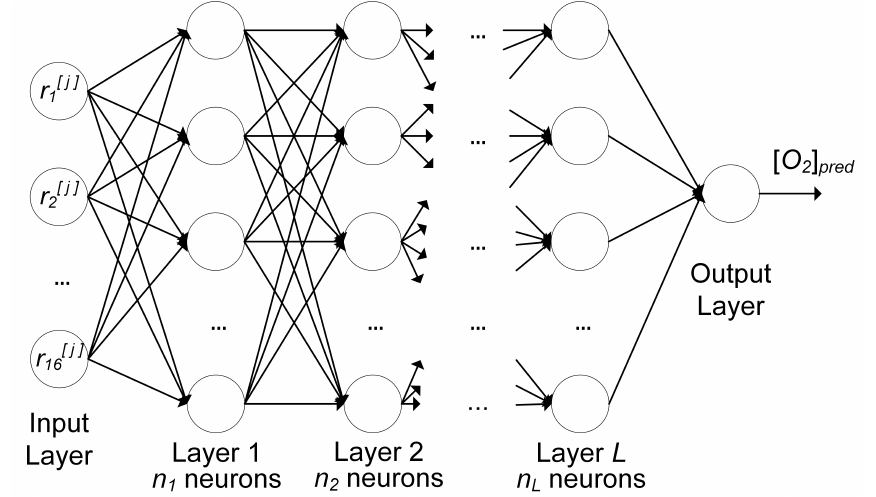
Figure 7. Architecture of the feed-forward neural network with L layers, each having a number [ j ] of neurons n i . r is the i th feature of the [ j ] th observation; the output is the predicted oxygen i concentration [ O 2 ] pred